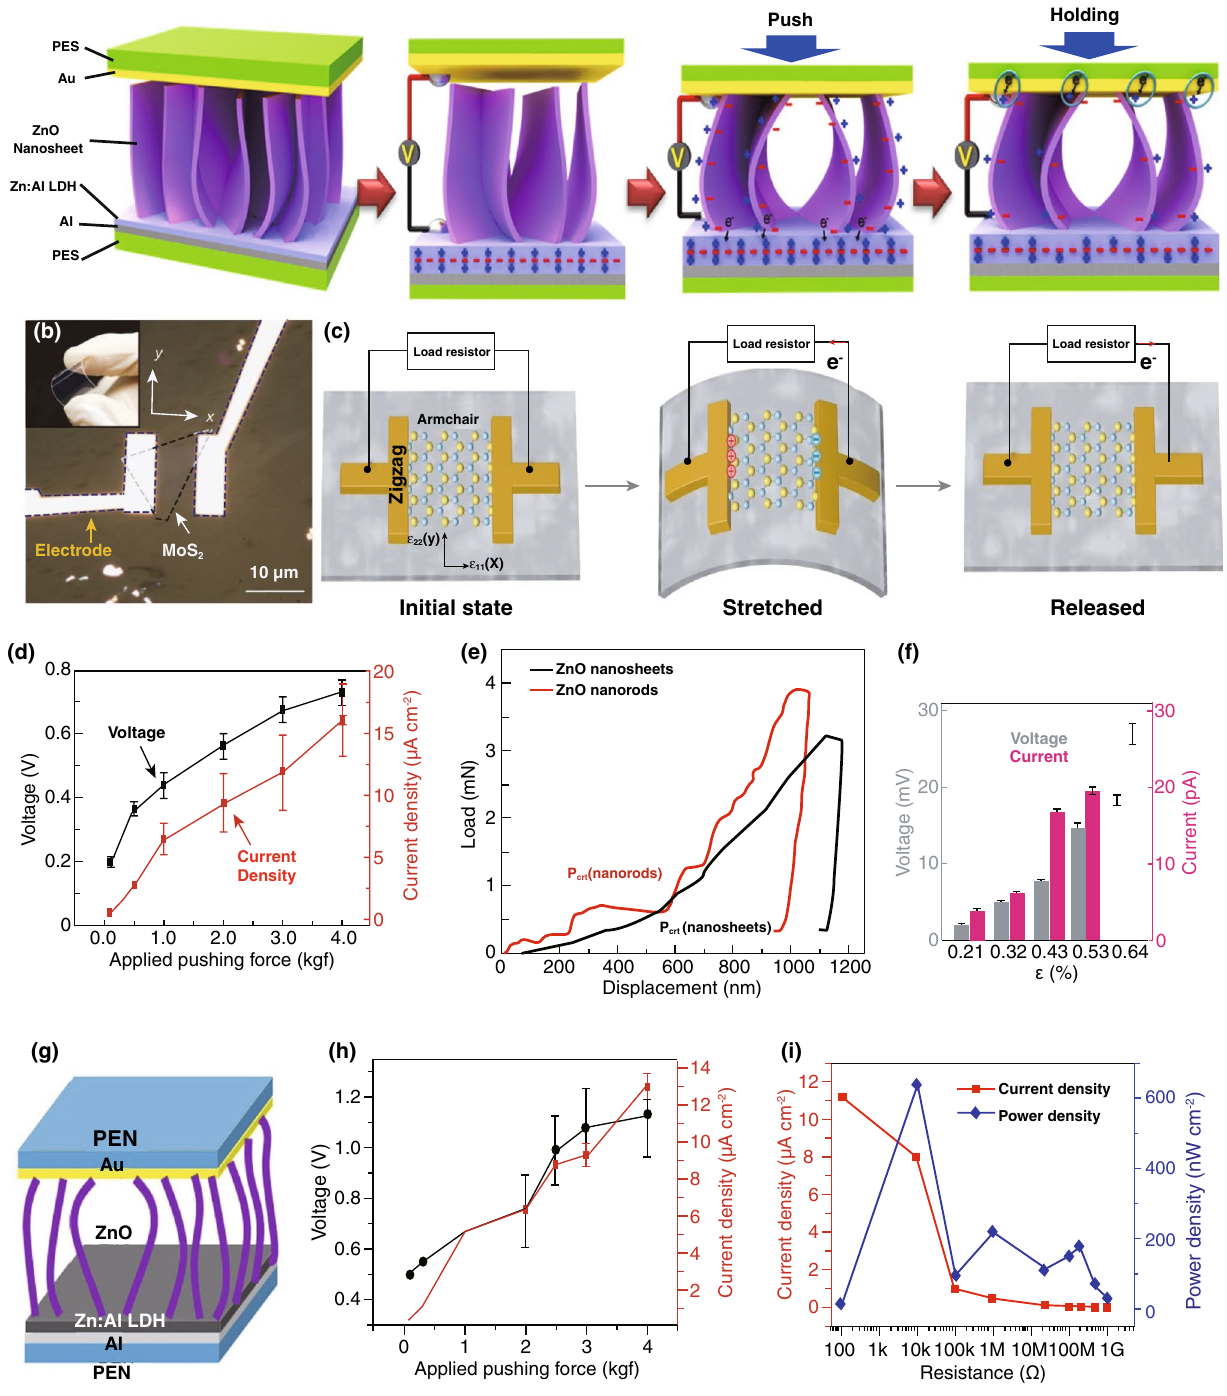
Fig. 6 Device structure, working mechanism, and performance of piezoelectric energy generation. a A two-dimensional ZnO-based nanogen- erator fabricated nano-clay-layered heterojunction and its working principle for energy scavenging. b A typical flexible nanogenerator based on single-layered MoS 2 nanoflake, including device image in inset. c Operating mechanism of the piezoelectric. d Resulting voltage and current according to the external vertical. e Plot of load–displacement of nanorods and nanosheets derived from ZnO. f Relation between the piezoelec- tric response and applied external strain. g Three-dimensional structure of ZnO nanosheet-based piezoelectric nanogenerator. h Effect of applied force on voltage and current. i Piezoelectric current along with power densities of the device with an external circuit resistance. Figures reprinted with permission from: a , d , e Ref. [93], © 2013 Nature; b , c , f Ref. [94], © 2020 Elsevier; g , h , i Ref. [95], © 2014